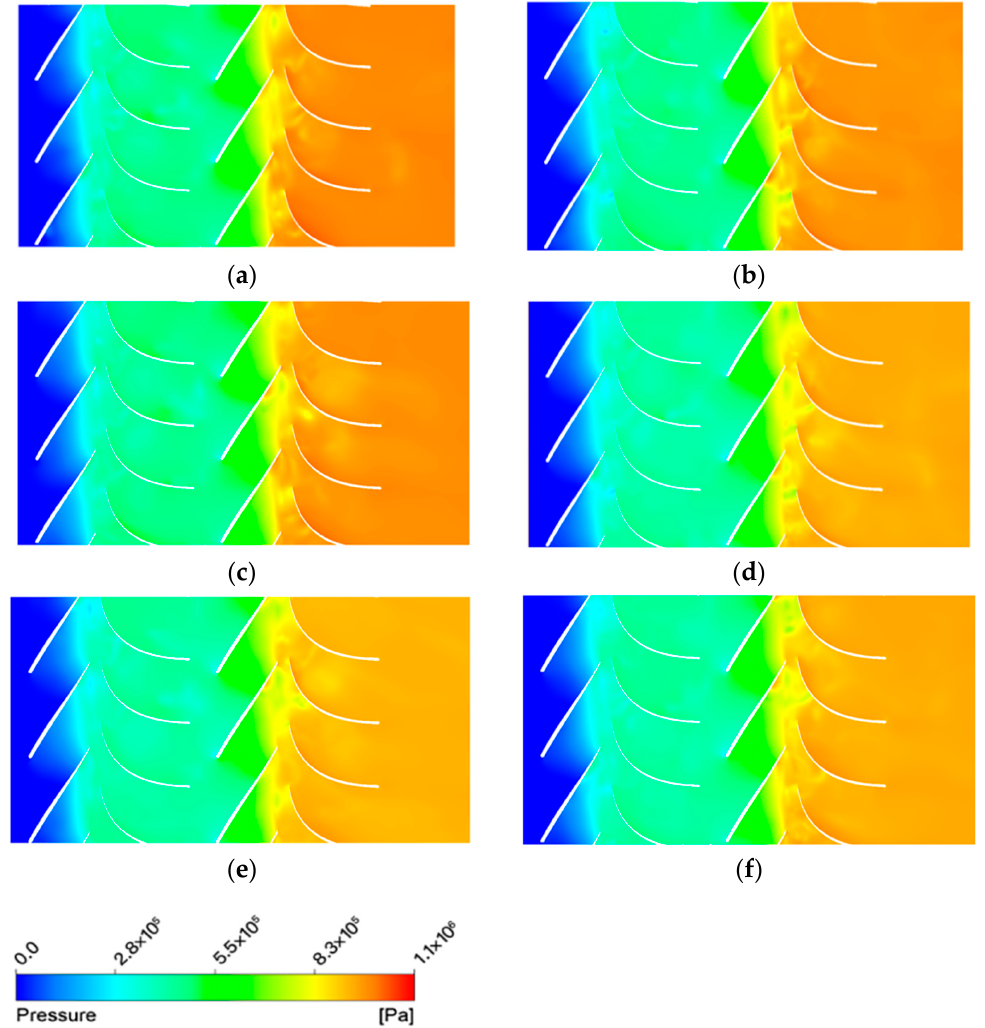
Figure 3. Pressure distribution on first-stage impeller-guide vane B2B view: ( a ) d p = 3 mm; ( b ) d p = 6 mm; ( c ) d p = 10 mm; ( d ) d p = 14 mm; ( e ) d p = 17 mm; ( f ) d p = 20 mm.